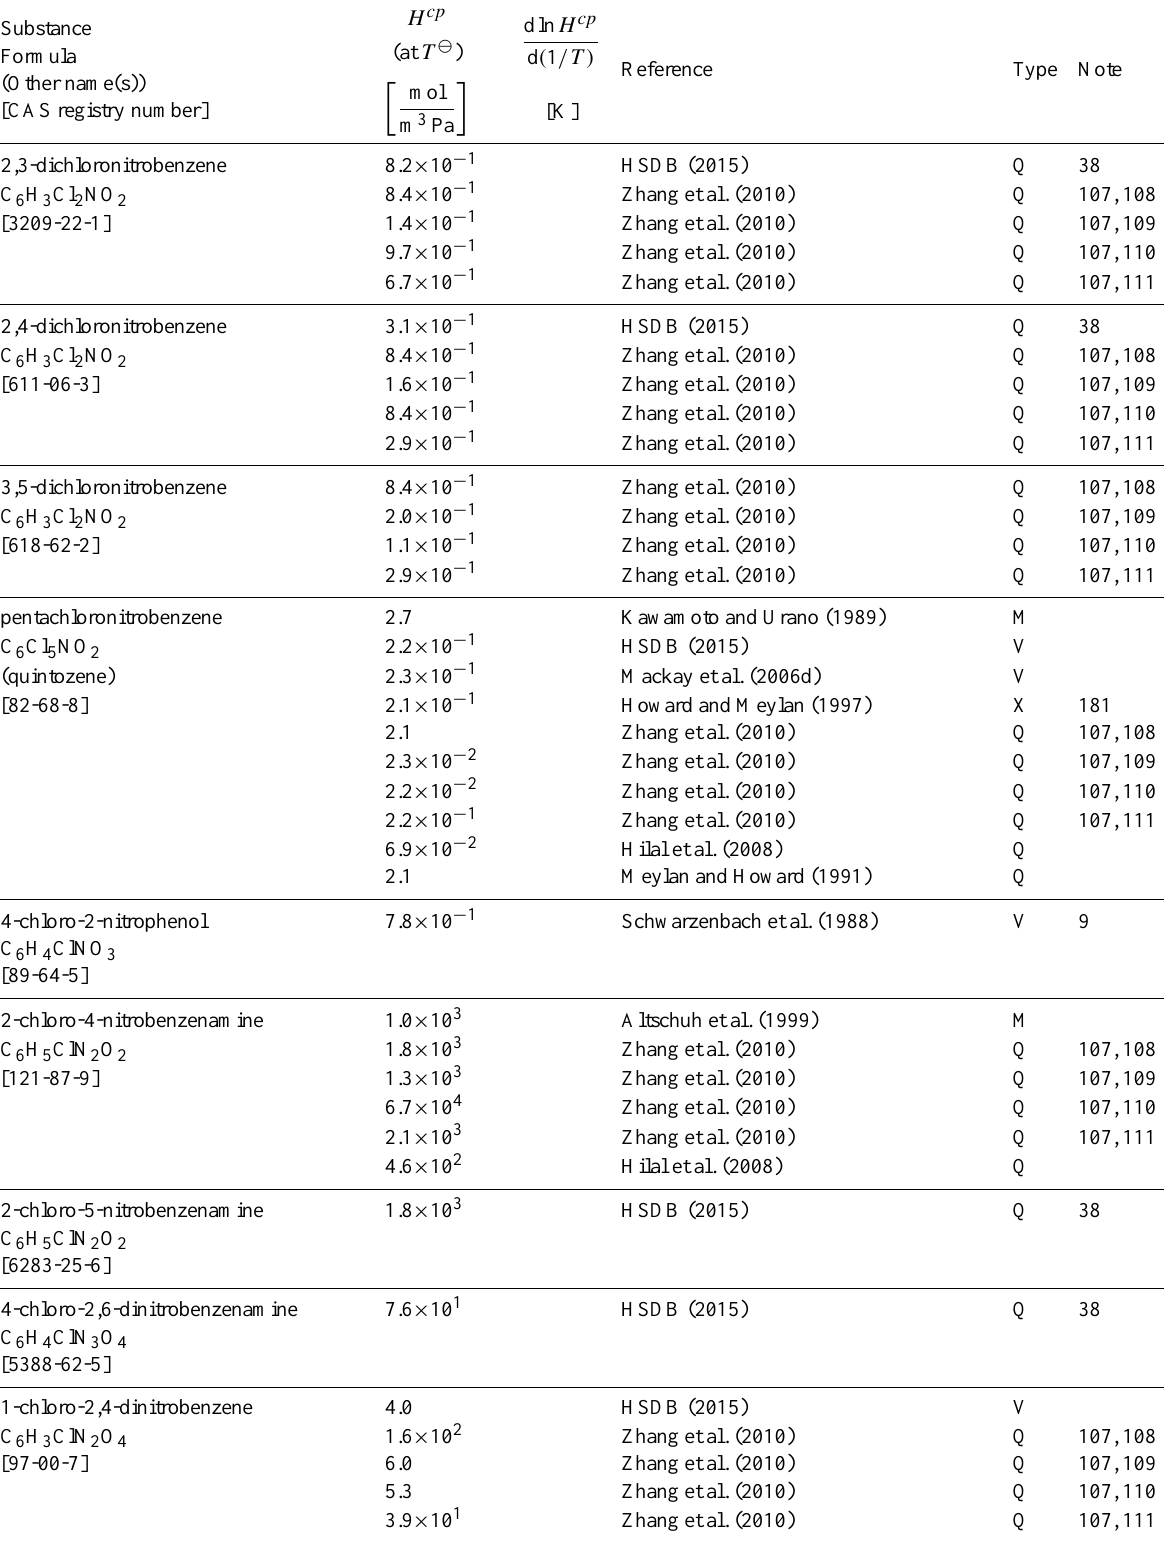
Table 6: Henry’s law constants for water as solvent